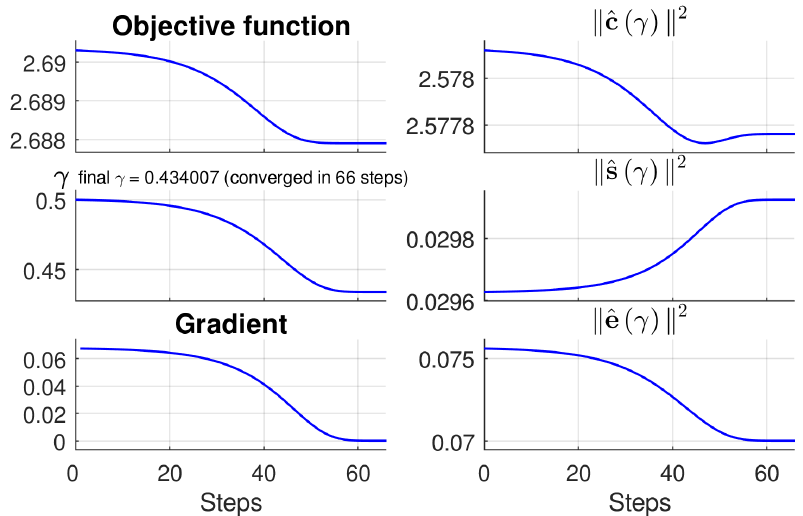
Figure 7. The progressive process of attaining γ ∗ for an intermediate virtual image using Equation (12) (taking I v in the top row of Figure 5 as an example).